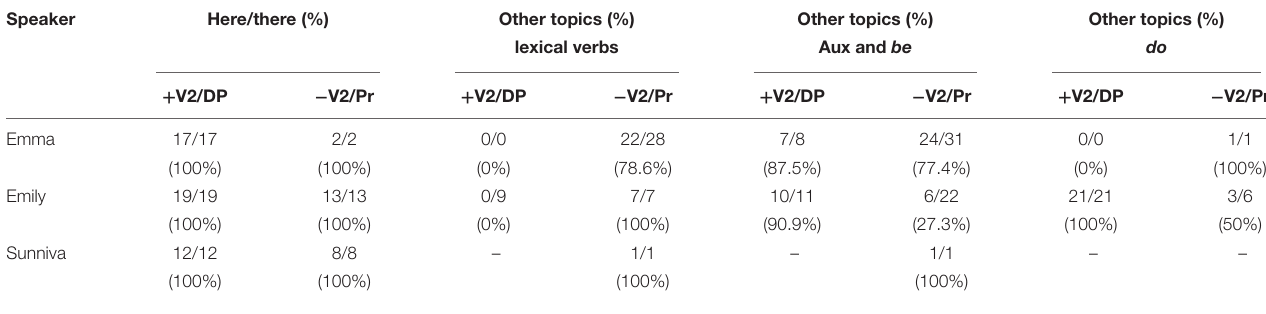
TABLE 12 | Subject types and verb placement in topicalisations with here/there (for Emma, Emily and Sunniva) compared to other topics (for Emma and Emily only), divided into verb types. Speaker Here/there (%) Other topics (%) Other topics